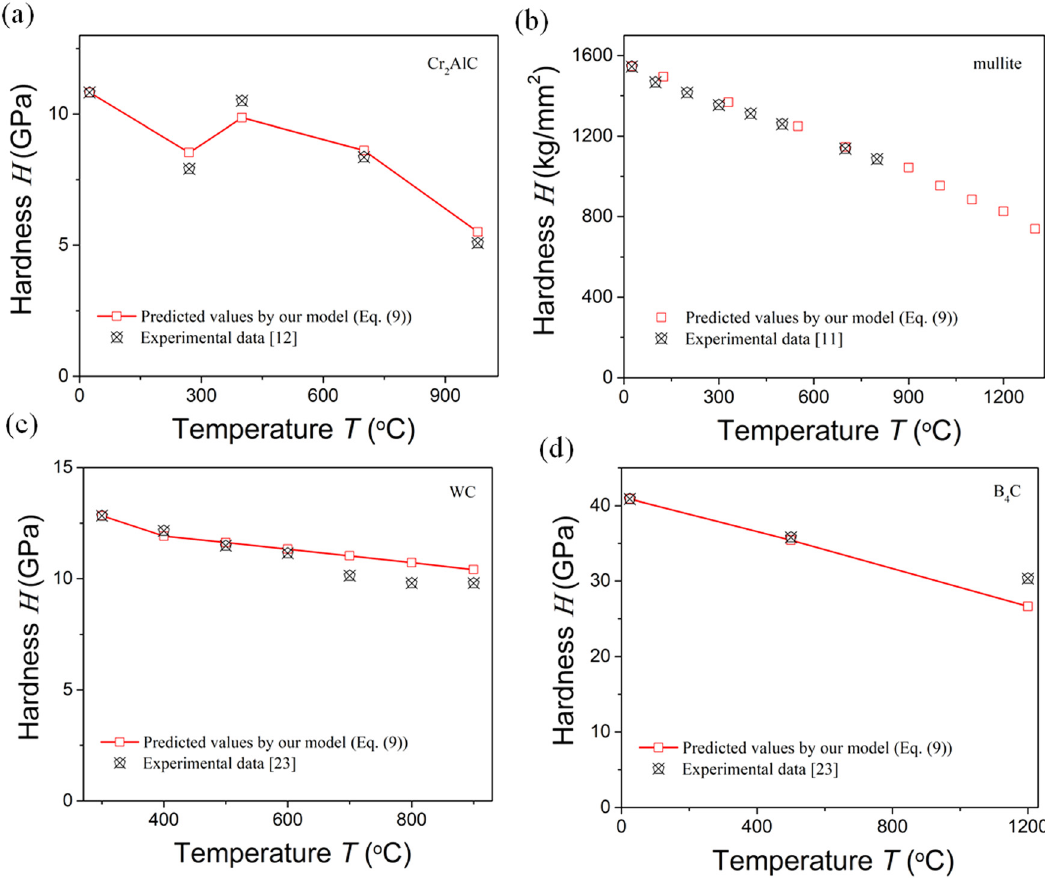
Figure 1: Comparison between the model - predicted and measured hardness of some ceramics at high temperature: ( a ) Cr 2 AlC, ( b ) mullite, ( c ) WC, and ( d ) B 4